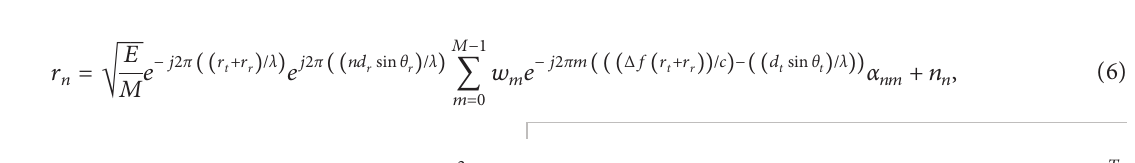
Figure 1: Schematic diagram of signal processing at the n th channel. (a) Standard FDA. (b)